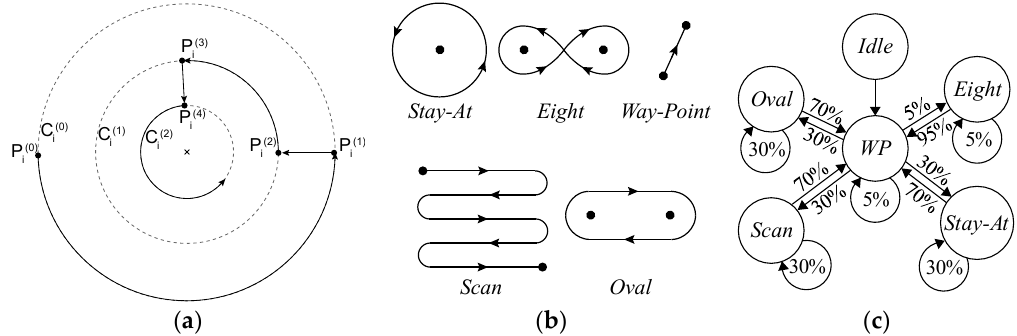
Figure 4. Path-Planned mobility trajectories: ( a ) Semi-Random circular mobility model; ( b ) Paparazzi autopilot UAV Movements ( Stay-At , Eight , Way-Point , Scan , and Oval ); and ( c ) PPRZM state machine.